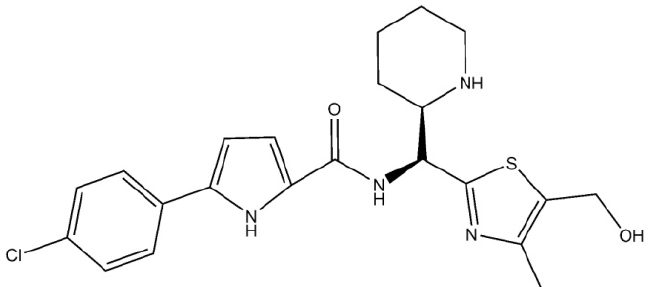
Figure 2. Chemical structure of NBD-11021, the lead viral entry antagonist that blocks gp120–CD4 interaction with pan-neutralization of diverse subtypes of clinical isolates (IC 50 as low as 270 nM) [35].